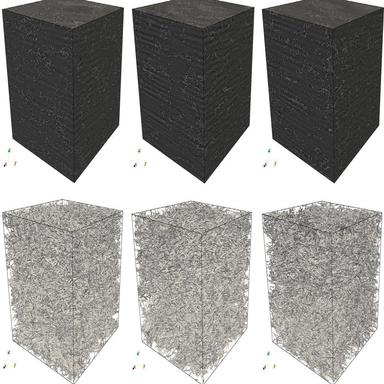
FiberFormTM micro-CT samples (A,B,C from left to right), before (top) and after (bottom) grayscale binarization via thresholding.